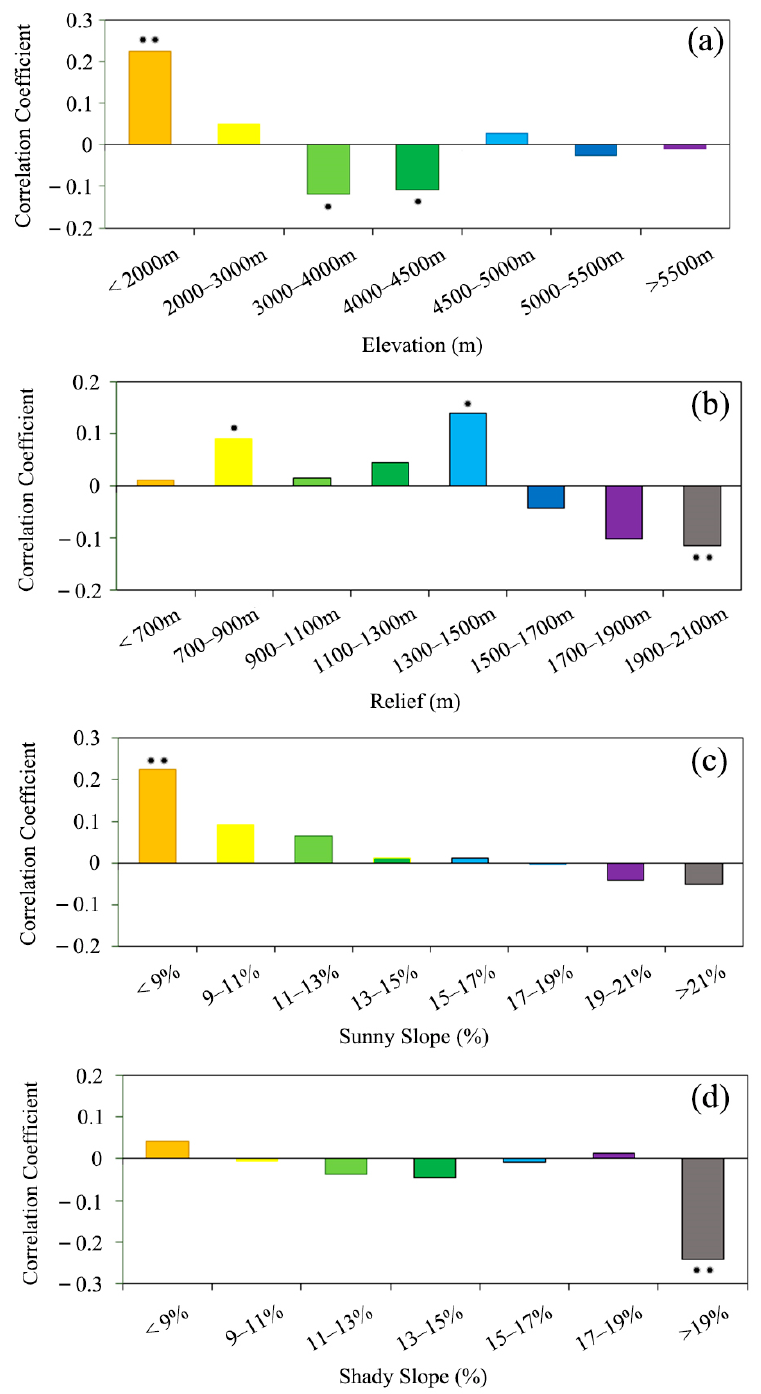
Figure 12. Relationships between elevation and AI ( a ), relief and AI ( b ), sunny slope area fraction and AI ( c ), and shady slope area fraction and AI ( d